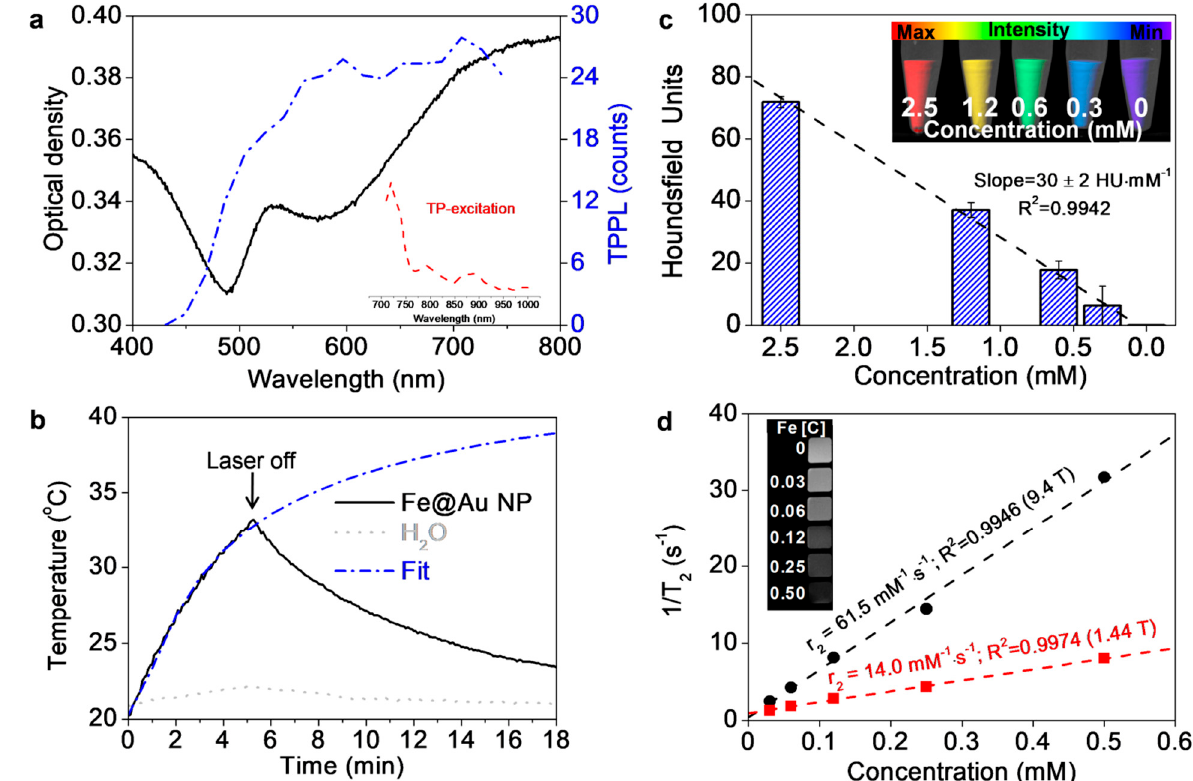
Figure 2. ( a ) Extinction spectra (dark line) and TPPL properties of the NPs suspension. Blue dashed line corresponds to TP-emission, while the inset represents the TP-excitation. ( b ) Phototermal conversion of the NPs. Black continuous line represents the temperature rise after laser radiation (1064 nm, 1.22 W/cm 2 ) and heat release after laser switch-off. The temperature rise of a control water sample is plotted as a continuous grey line. Blue line is the fit of the experimental data to the analytical solution of the Fourier equation of a continuous point source. ( c ) X-ray attenuation intensity measurement calculated by the slope of the linear fit of CT values against NP concentrations. Inset: CT image of the different concentrations of Fe@AuNPs. ( d ) Plot of 1/T 2 over nanoparticle concentration at 1.44 and 9.4 T. Inset: T 2 weighted image of different NPs concentrations at 9.4 T. r 2 values are drawn on each linear fit (dashed lines).